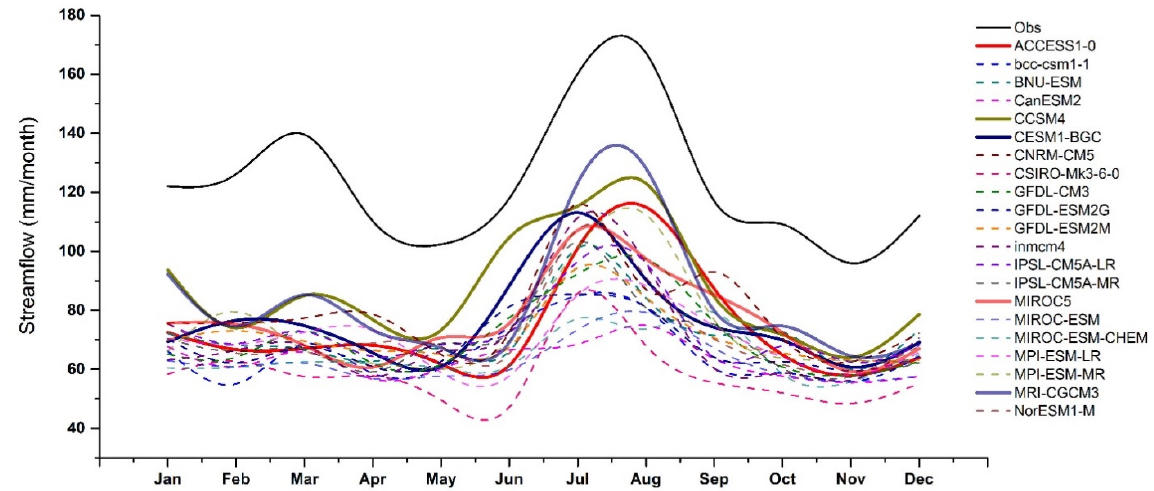
Figure 5. Monthly streamflow simulated by the HBV-light model in the Chirah sub catchment for 1980–2004 by using observed (gauge-based, in black) and GCM (NEX-GDDP, in colors) climate inputs.